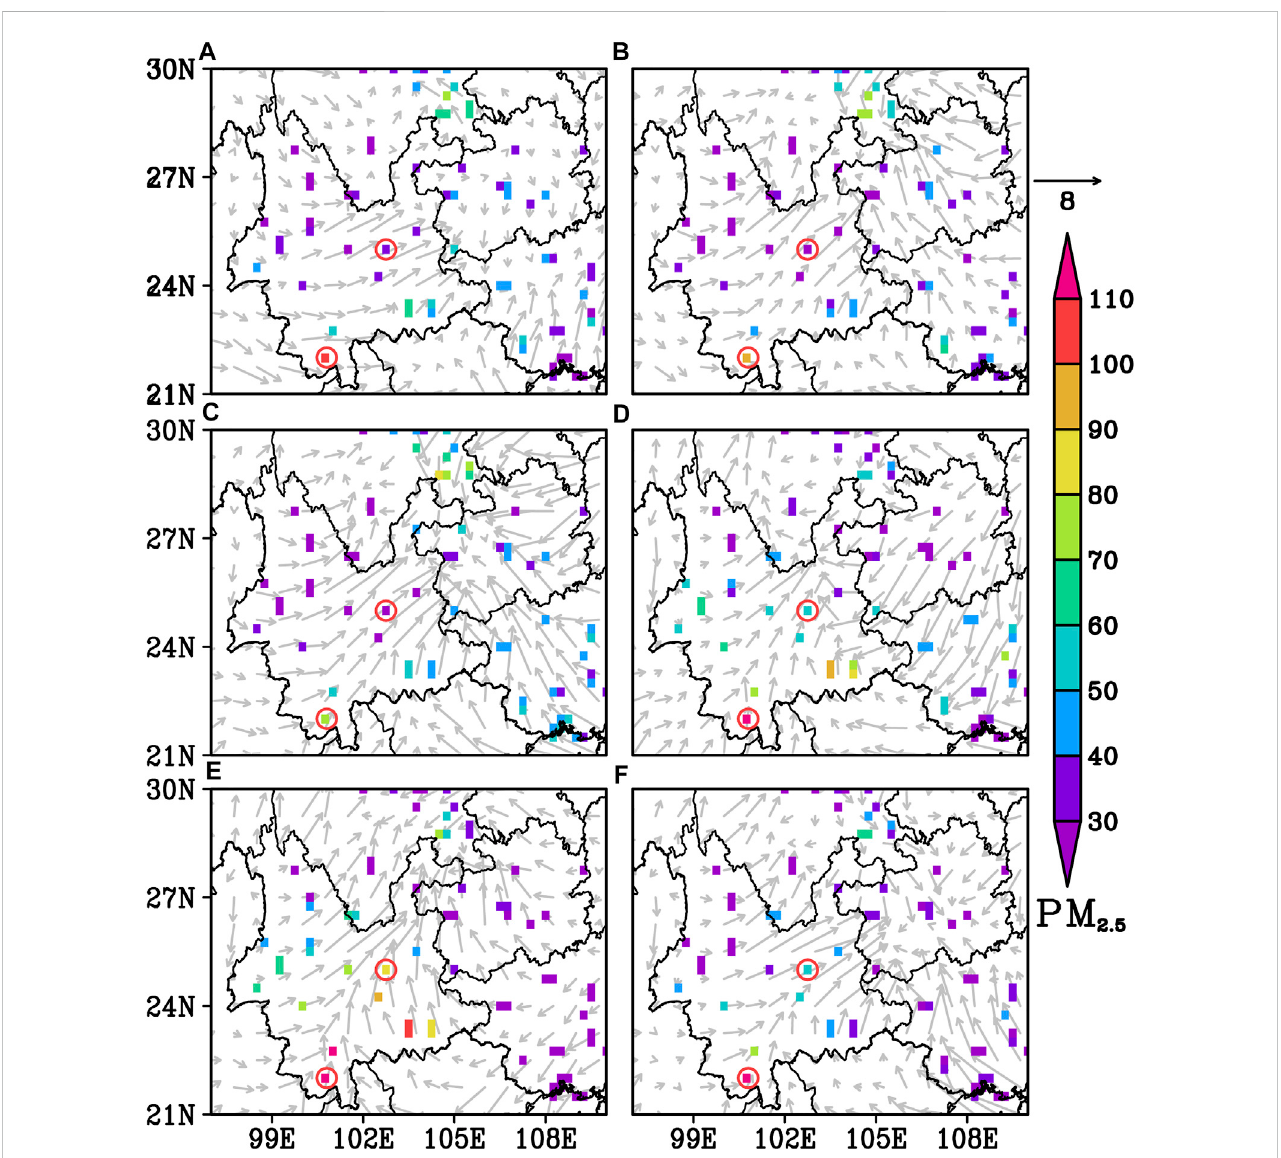
FIGURE 8 The daily means wind vectors (m s − 1 ) and PM 2.5 ( μ g m − 3 , fi ll color) concentrations near the surface in the Low-latitude Plateau from 28 March 2019 to 2 April 2019 (A – F) . The red circles denote the location of Kunming (KM, Northeast) and Jinghong (JH,